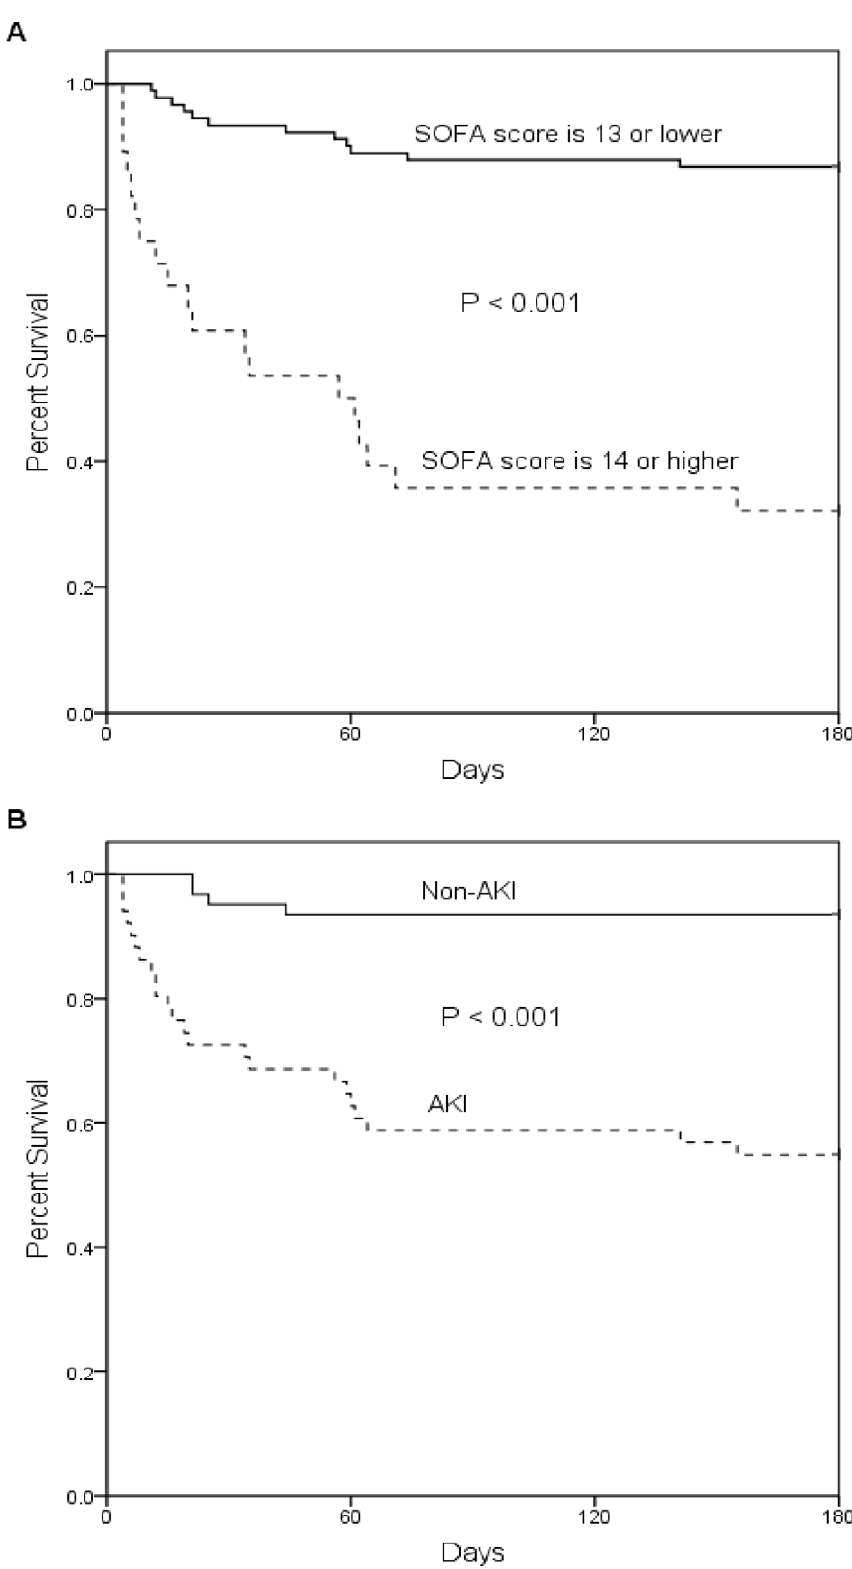
Figure 1. Cumulative survival rate for 119 critically ill patients based on (A) sequential organ failure assessment (SOFA) score on the day of ECMO removal and (B) acute kidney injury (AKI) or not based on changes over the course of 48 hours after ECMO removal. AKI defined as in the AKIN 48-hour classification system with stage 1, 2 and 3.